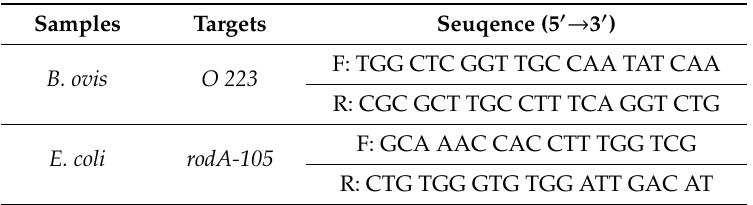
Table 1. Primer sets for qPCR and